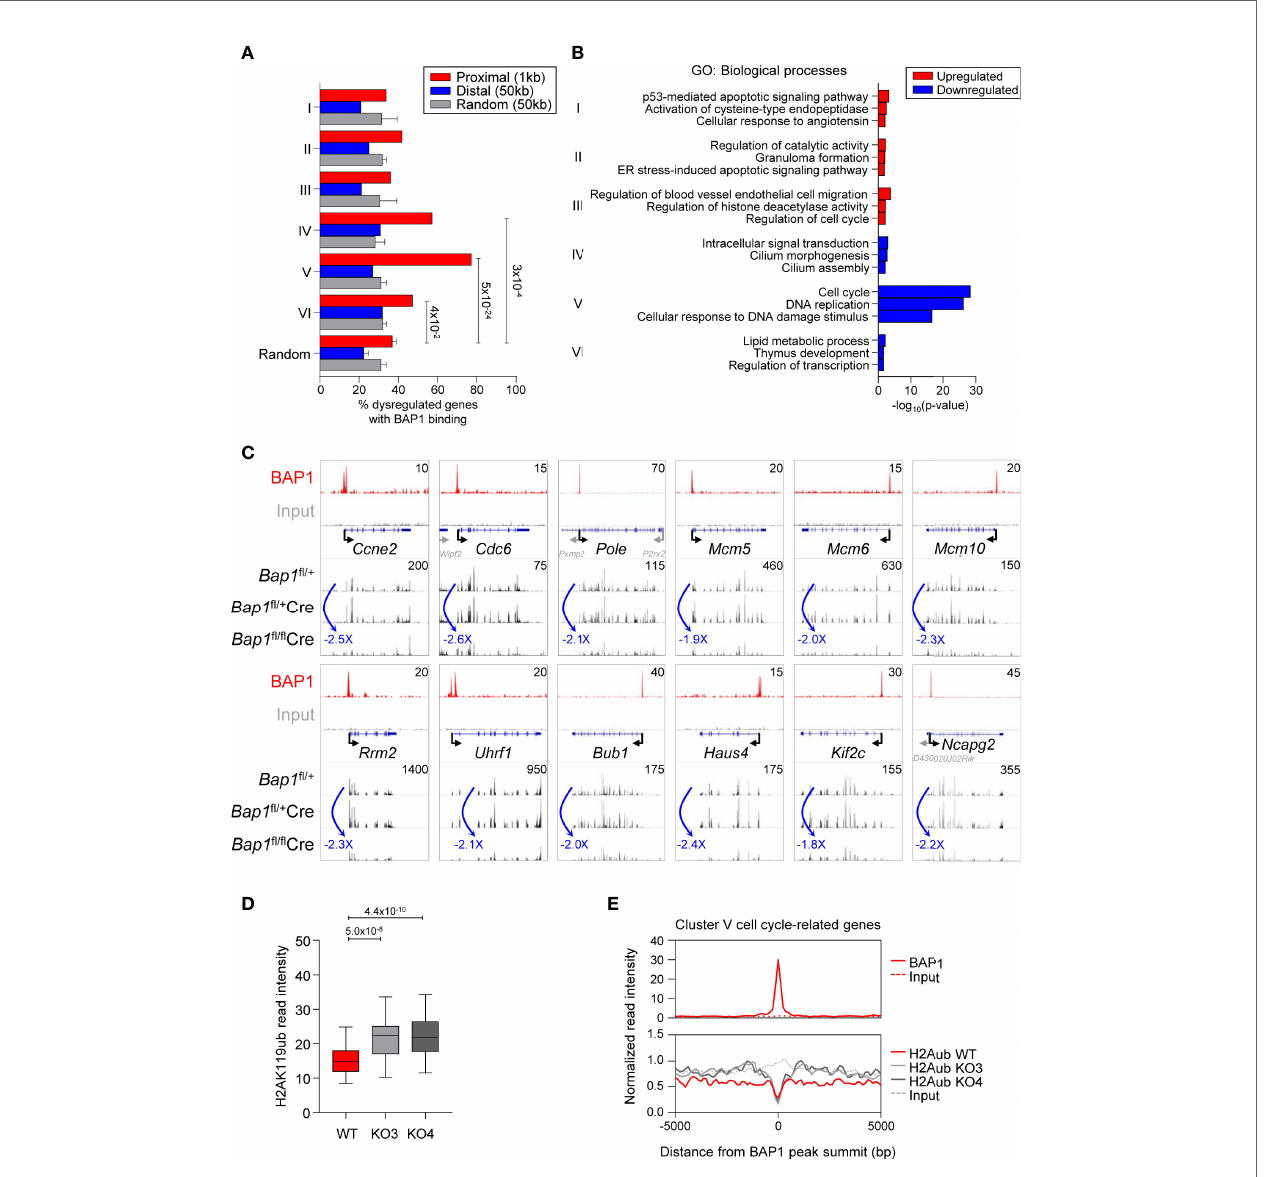
FIGURE 7 | BAP1 in the regulation of genes involved in cell proliferation and cell cycle progression in pre-B cells. (A) Consolidation of the RNA-Seq and ChIP-Seq datasets, described in Figures 4 and 6 , showing the percentages of genes dysregulated in expression in Bap1 fl / fl Cre cells with at least one BAP1 binding site within the indicated range of their TSS. Analysis is performed for each of the Cluster I-VI of the genes dysregulated in Bap1 fl / fl Cre cells, as de fi ned in Figure 4D . The random genes cluster consists of ten groups of 300 genes randomly selected from 24,421 genes in the mm9 genome. The random binding sites consist of ten groups of 10,000 genomic locations randomly selected from the mm9 genome. Fisher Exact Test is used to calculate the p -values. (B) Gene ontology (GO) enrichment analysis for the Clusters I-VI genes, dysregulated in expression in Bap1 fl / fl Cre cells, and containing a proximal or distal BAP1 binding site. Top three enriched biological process terms per Cluster are displayed. (C) Genomic snapshots of selected genes that represent the putative direct transcriptional targets of BAP1 in pre-B cells. The genes are selected from Cluster V genes that are downregulated in expression in Bap1 fl / fl Cre pre-B cells, carry a proximal or distal BAP1 binding site, and are functionally linked to cell proliferation and cell cycle progression. ChIP-Seq tracks for BAP1 and input DNA are shown on the top two lanes. The gene feature track is shown in the middle. Averaged RNA-Seq tracks for pre-B cells are in the bottom three lanes, with fold changes comparing expression levels in Bap1 fl / fl Cre and control Bap1 fl /+ samples indicated. The maximum data range of each track is indicated at the top-right corner of the track. (D) Box plot showing histone H2AK119ub read intensities ±2.5kb to BAP1 binding sites near putative BAP1-regulated Cluster V genes, functionally linked to cell proliferation and cell cycle progression; (GO terms: GO:0007049 ~cell cycle; GO:0006260 ~DNA replication; GO:0051301 ~cell division; mmu04110: Cell cycle; and/or mmu03030: DNA replication, 69 genes in total, Table S1G ). The Mann-Whitney U test was used to calculate the p -values. (E) Histograms showing the average normalized read intensities of BAP1 and histone H2AK119ub at the BAP1 binding sites proximal to the select subset of Cluster V genes, functionally linked to cell proliferation and cell cycle progression, as speci fi ed above. The read intensities of BAP1 are determined from the ChIP-Seq data of WT and FLAG x3 Ba/F3 cells, and the read intensities of histone H2AK119ub are from the ChIP-Seq data of WT and two Bap1 D / D (KO) Ba/F3 cell